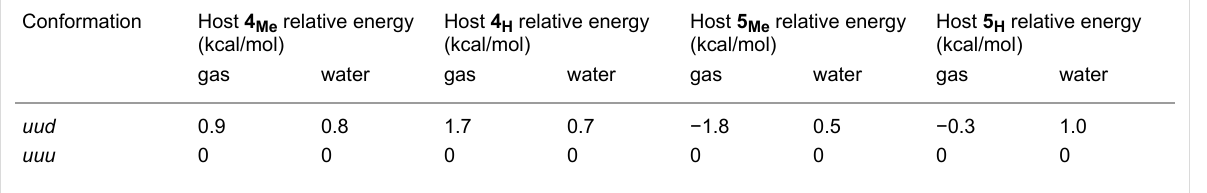
Table 6: Calculated energies for conformations of test hosts 4 Me , 4 H , 5 Me , and 5 H .